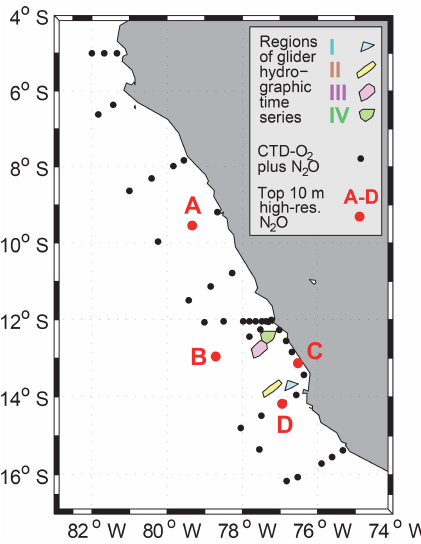
Figure 1. Locations of sample stations and glider time series off the coast of Peru, December 2012 to February 2013. Black dots: simul- taneous CTD − O 2 and N 2 O sampling, comprising 5 and 10m depth samples, during M91 (3–23 December 2012). Red dots: Zodiac- based high-resolution N 2 O profiles of topmost 10m; A: 8 Decem- ber 2012 at 16:30 local time; B: 13 December 2012 at 10:00 lo- cal time; C: 16 December 2012 at 14:30 local time; D: 17 Decem- ber 2012 at 14:00 local time. Colored areas: regions where time series of glider near-surface hydrography were obtained; I: 10 days from 17 to 27 February 2013; II: 22 days from 23 January to 22 February 2013; III: 31 days from 15 January to 15 February 2013; IV: 37 days from 11 January to 17 February